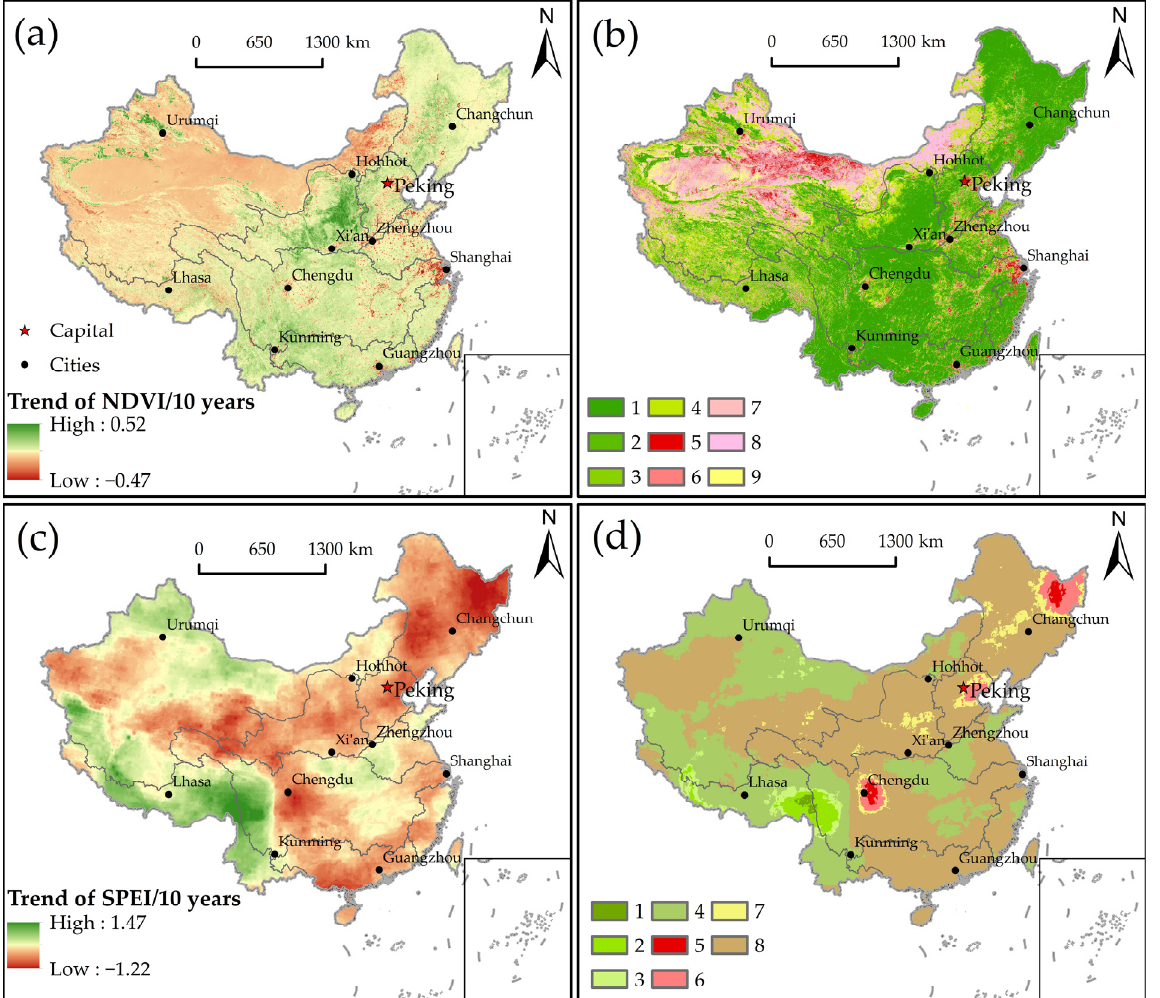
Figure 3. ( a ) Spatial distribution of the trend in the NDVI in China during 1998 ‒ 2017; ( b ) spatial distribution of significant changes in the NDVI in China from 1998 ‒ 2017; ( c ) spatial distribution of the trend in the SPEI in China during 1998 ‒ 2017; and ( d ) spatial distribution of significant changes in the SPEI in China from 1998 ‒ 2017.